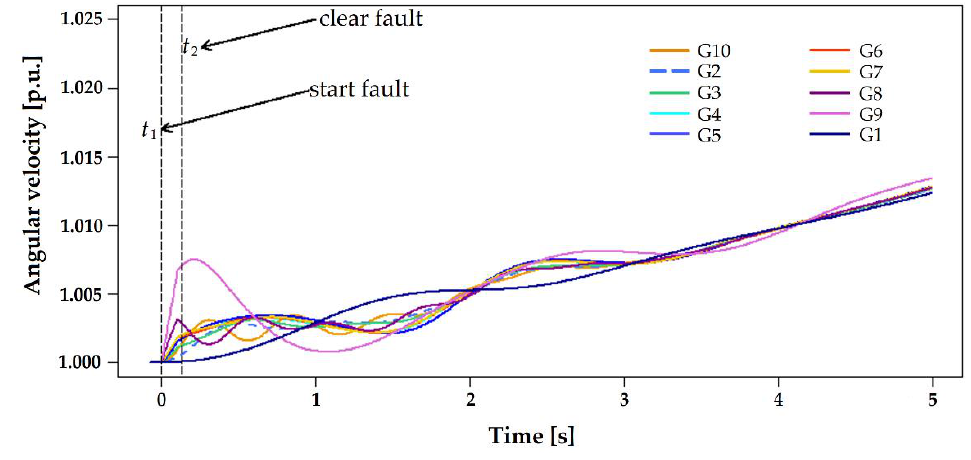
Figure 14. Rotor speed of generators with a fault in line 26–28.